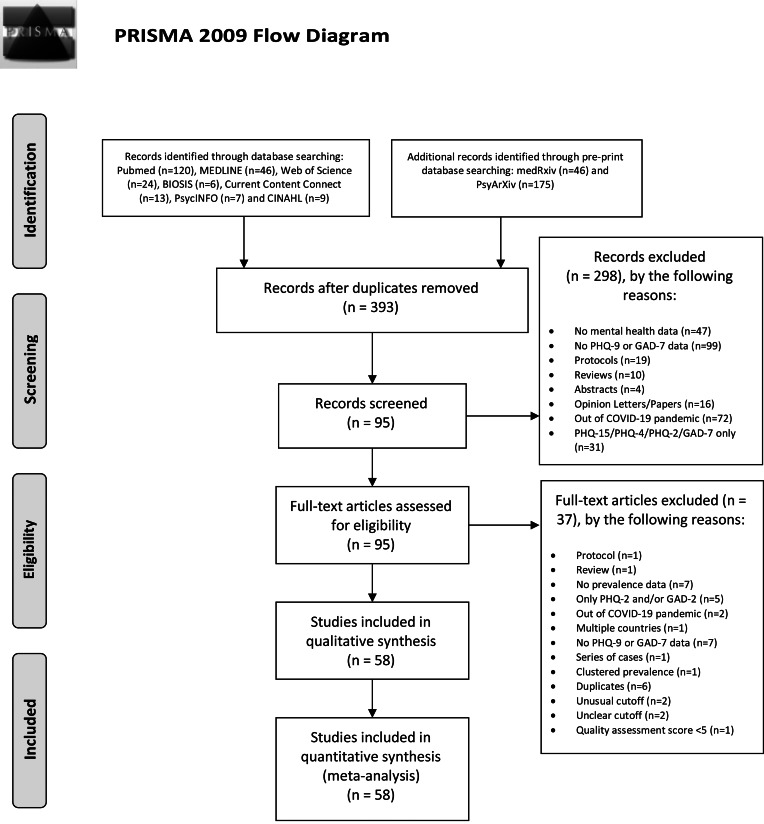
PRISMA Flow Diagram.